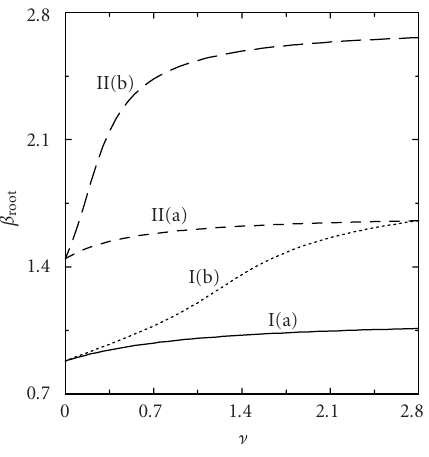
Figure 4.7. The variation of β root as a function of the nonintegrability parameter ν for two positive values of the parameter a . The exact solution for λ = 1. For curves I(a) and I(b), a = 1, but x 0 = 0 . 5 and 0 . 0, respectively. For curves II(a) and II(b), a = 2 . 0, but x 0 = 0 . 5 and 0 . 0,